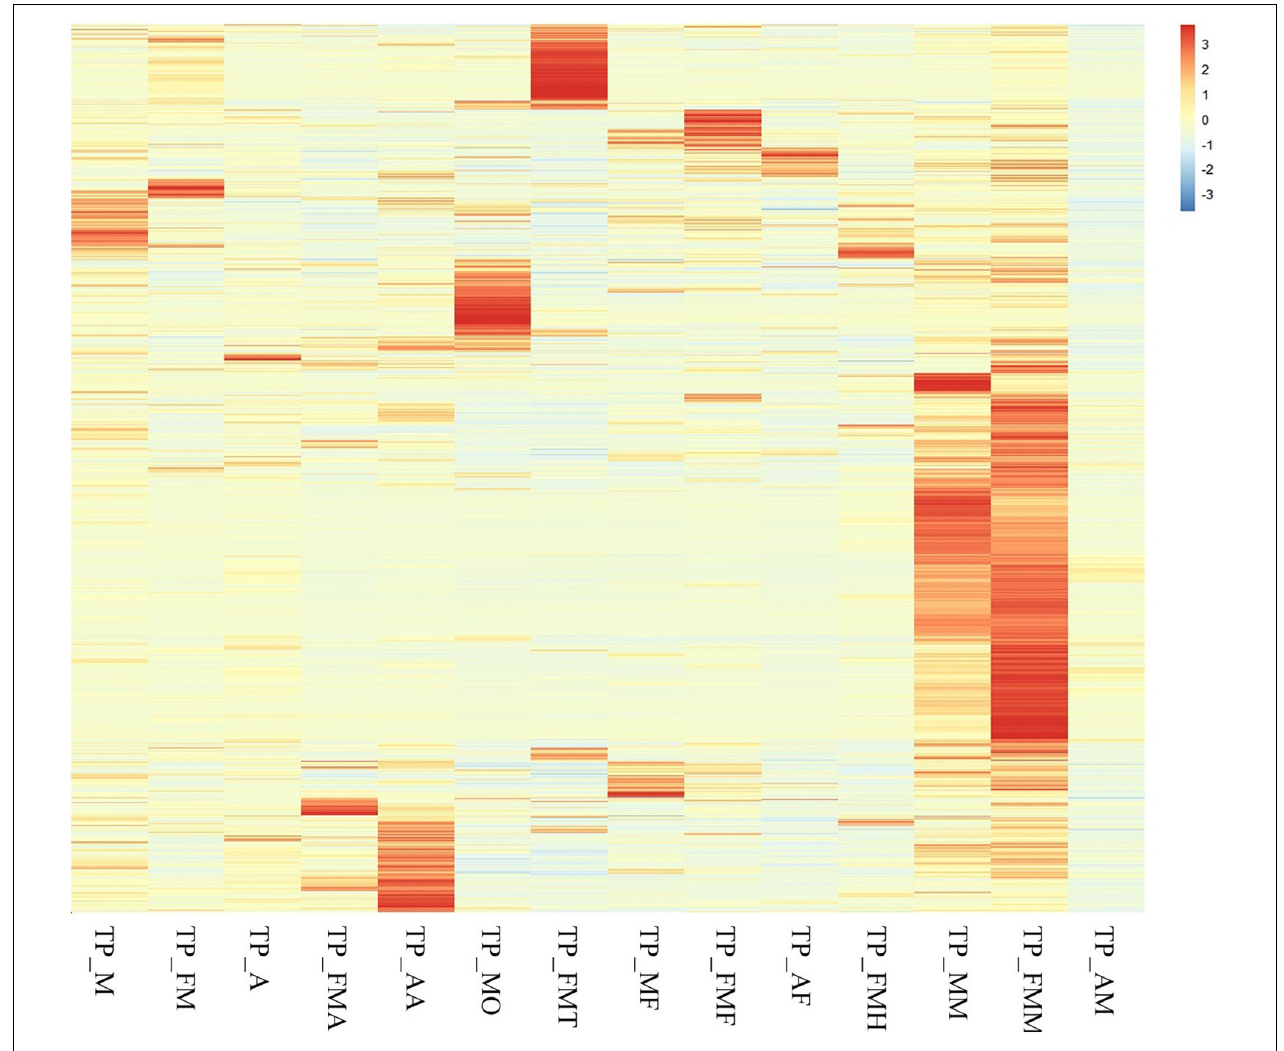
FIGURE 5 | Cluster analysis of all genes among different tissue samples and different developmental